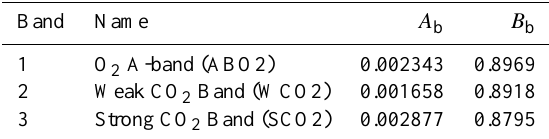
Table 3. Empirical noise coefficients.